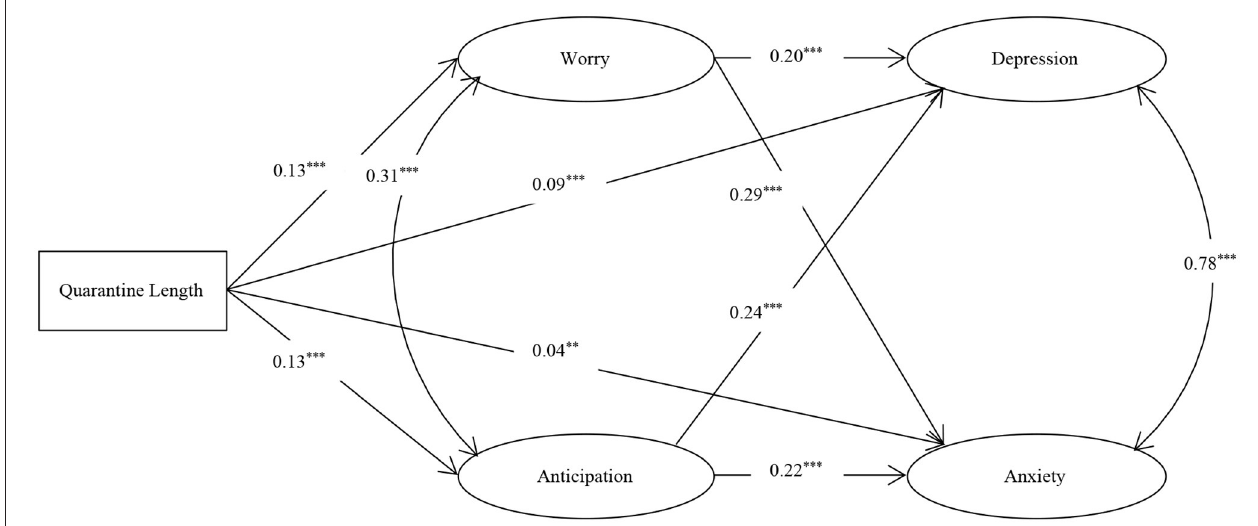
FIGURE 1 | The multiple mediation model among quarantine length, worry, anticipation, depression, and anxiety. *** p < 0.001, ** p < 0.01.